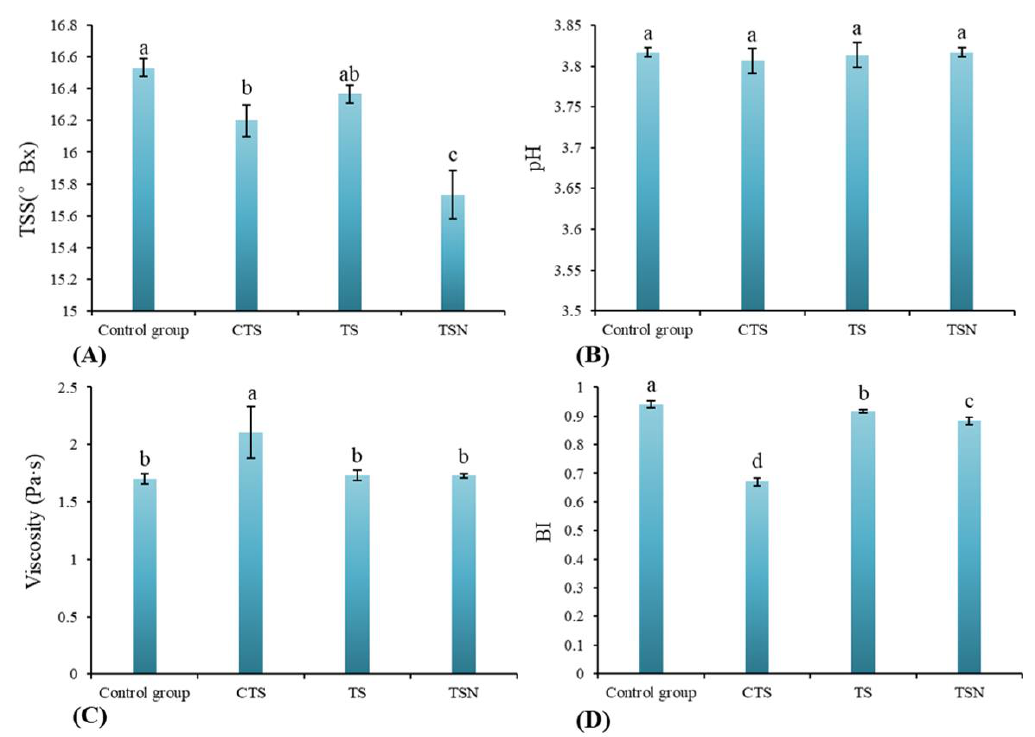
Figure 4. Effects of different sterilization treatments on the physicochemical properties of grape juice. ( A ) Total soluble solids (TSS); ( B ) pH; ( C ) browning indexes (BI); and ( D ) viscosity.